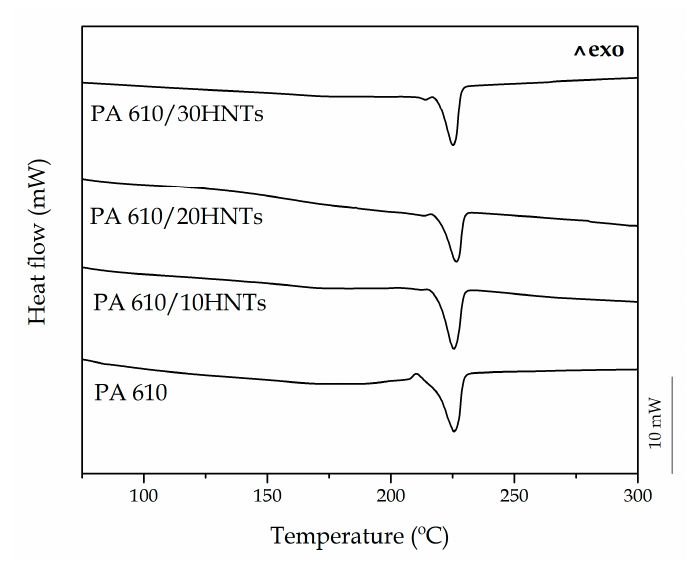
Figure 3. Di ff erential scanning calorimetry (DSC) thermograms of PA610 composites with di ff erent Figure 3. Differential scanning calorimetry (DSC) thermograms of PA610 composites with different HNTs HNTs loading. Table 3. Mai n thermal parameters of the injection-molded parts of polyamide 610 (PA610) with HNTs in terms of: melting temperature (T m ), normalized melting enthalpy ( ∆ H m ), and percentage of crystallinity ( χ c ).